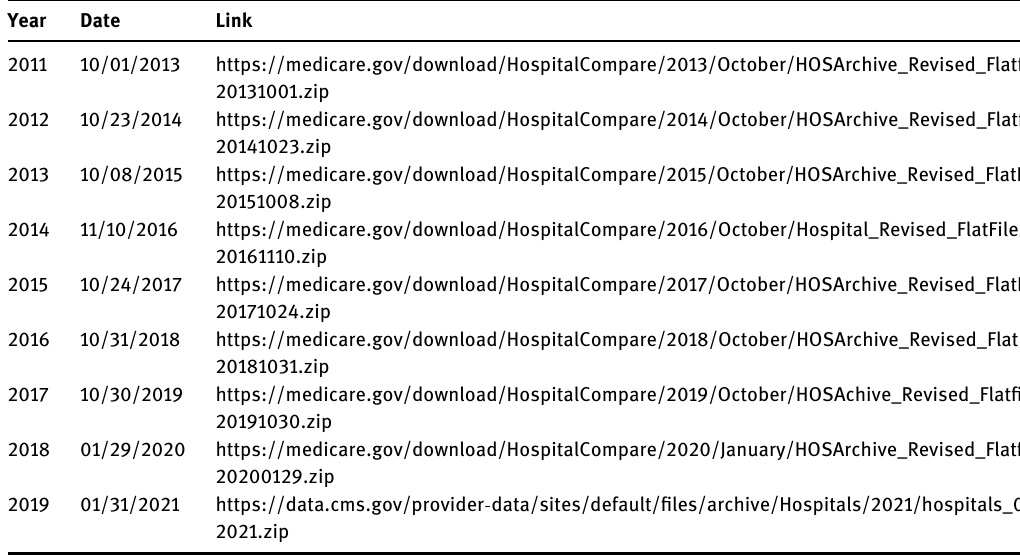
Table A3: Download links for the TPS